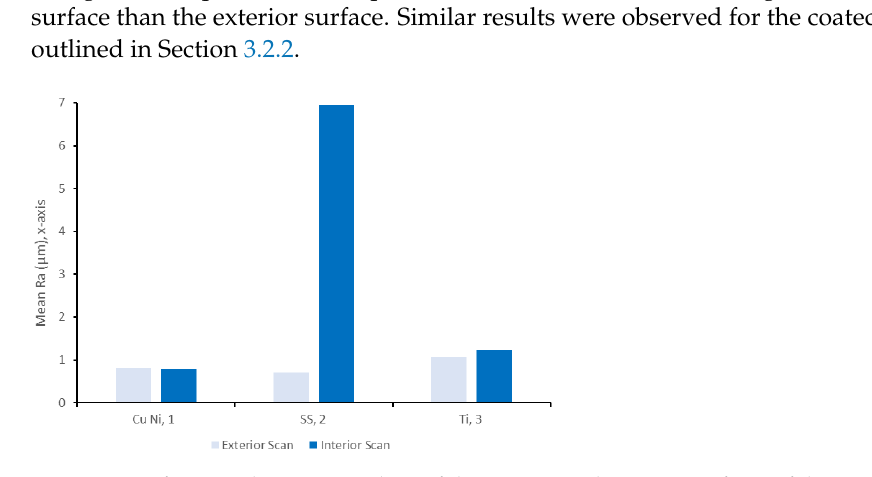
Figure 8. Surface roughness, Ra, values of the interior and exterior surfaces of the uncoated samples compared to the mean of the coated samples.